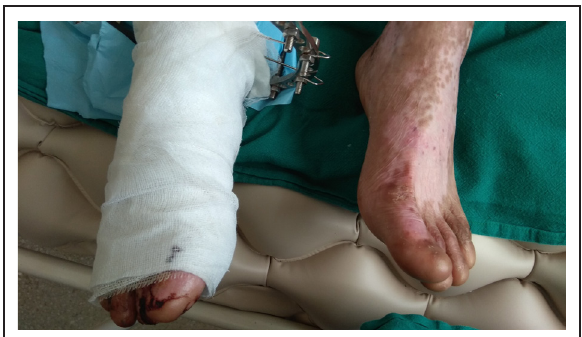
Figure 2. Right leg with Illizarov prior to below knee disarticulation. His grade IIIC fracture of middle one- third of both bones of right leg was managed with Illizarov and K-wire. Bilateral feet without nails since birth. Few crusted lesions following blister rupture along with hypopigmented areas at previously healed lesions.